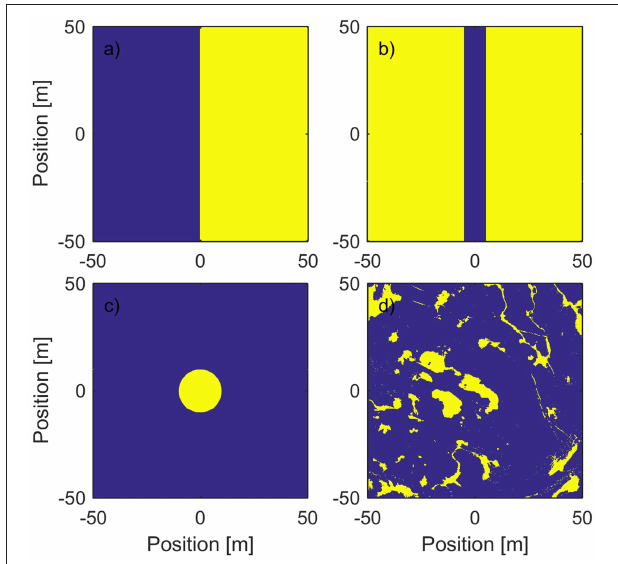
FIGURE 2 | The different geometries used in this study. Yellow color depicts high light transmittance and blue color low light transmittance. The surface geometries resemble (A) a floe edge, (B) a pressure ridge, (C) a melt pond, and (D) a real geometry of melt pond covered sea ice extracted from